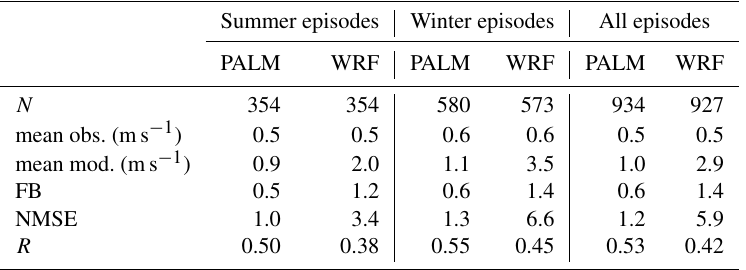
Table 4. Statistical metrics of modelled 1h averaged wind velocities within different street canyons. The statistics are evaluated over all locations and episodes considered. Summer and winter episodes are distinguished. The statistical metrics for the modelled 10m wind speed in WRF are also given for